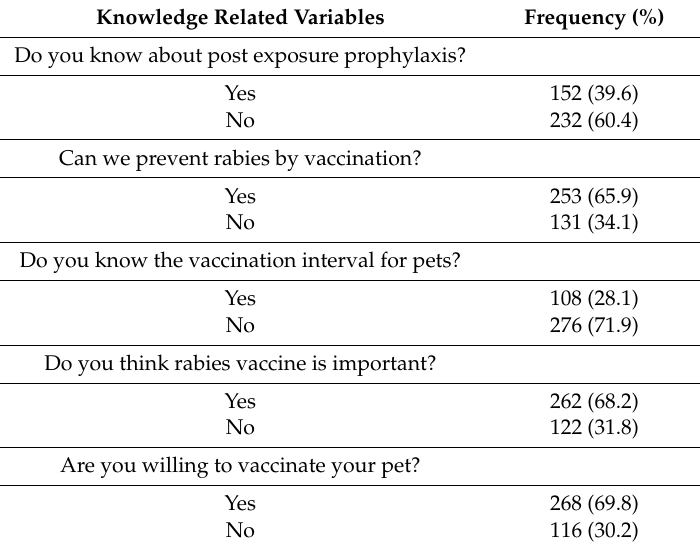
Table 4. Knowledge of the study participants for prevention and control towards rabies (N = 384).